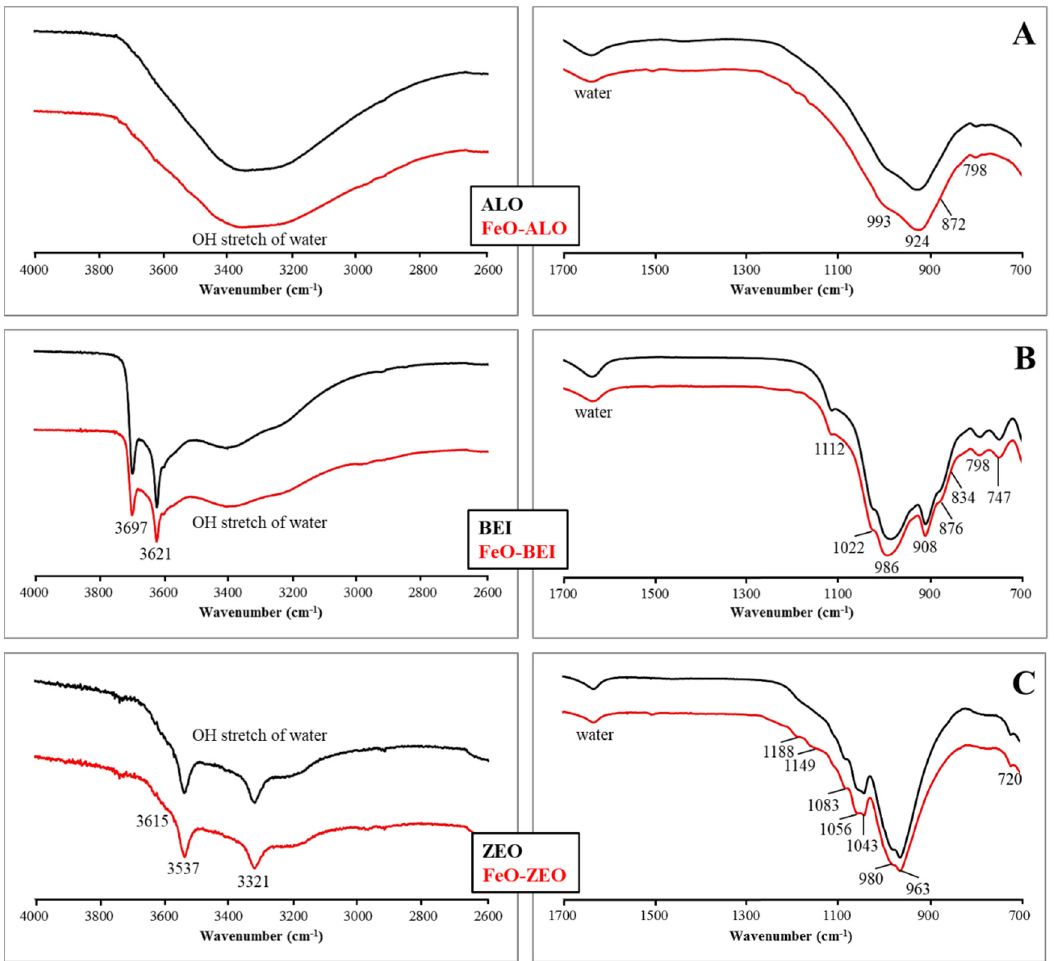
Figure 3. ATR-FTIR spectra of natural and FeO-modified ALO ( A ), BEI ( B ) and ZEO ( C ). Left panel) Hydroxyl stretching region. Right panel) Lattice vibration region.